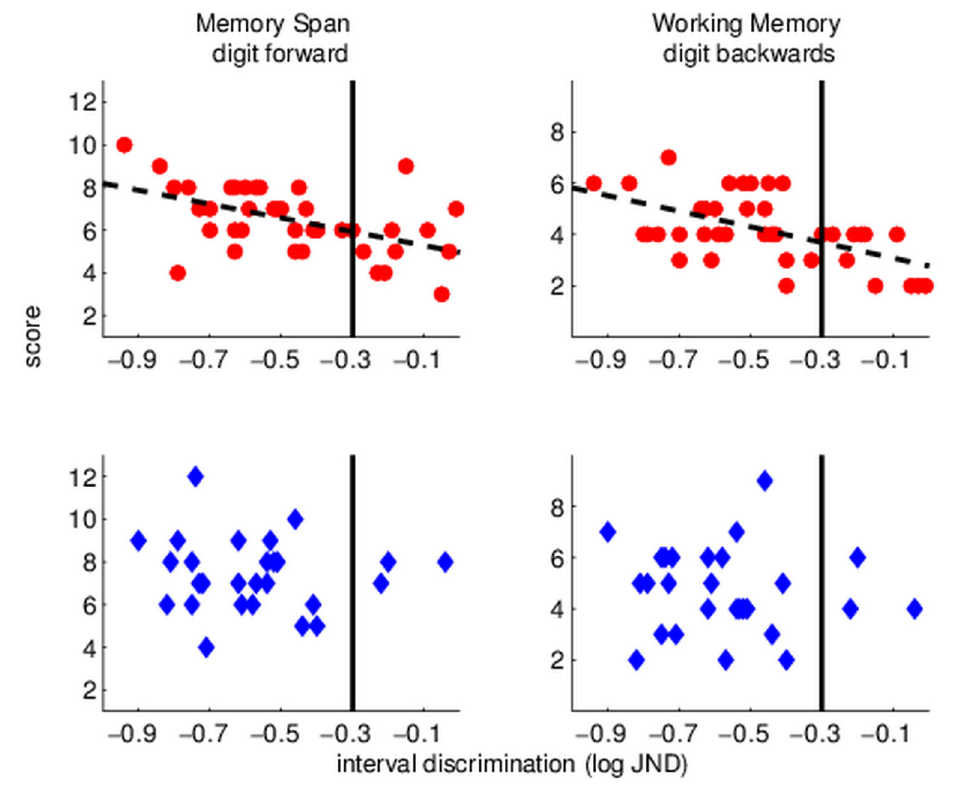
Figure 3. Scatter plots illustrating the relationships between temporal-interval discrimination and two aspects of verbal memory, simple span (Digit forward; left) and working memory (Digit backward; right) in musically naïve (top panels) and musically experienced (more than a year of training; bottom panels) children. Among musically naïve children 10/40 have poor (> 50%) thresholds (right of the vertical lines denoting JND = -0.3). These children tend to have poorer memory spans, particularly poor working memory span (top right panel). doi: